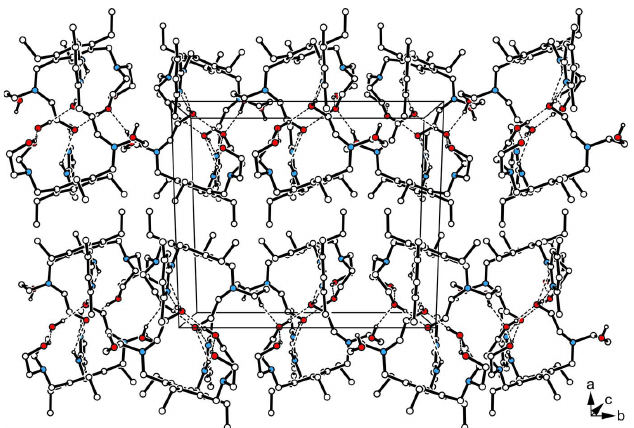
Figure 4 Packing diagram of the title compound viewed down the c axis. Oxygen atoms are displayed as red, nitrogen atoms as blue circles. Hydrogen- bonding interactions are shown as dashed